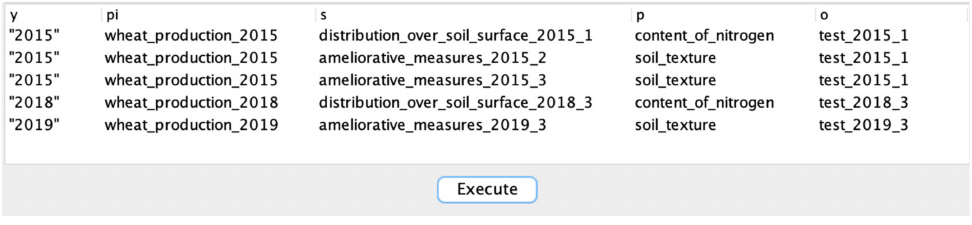
Figure 5. The query